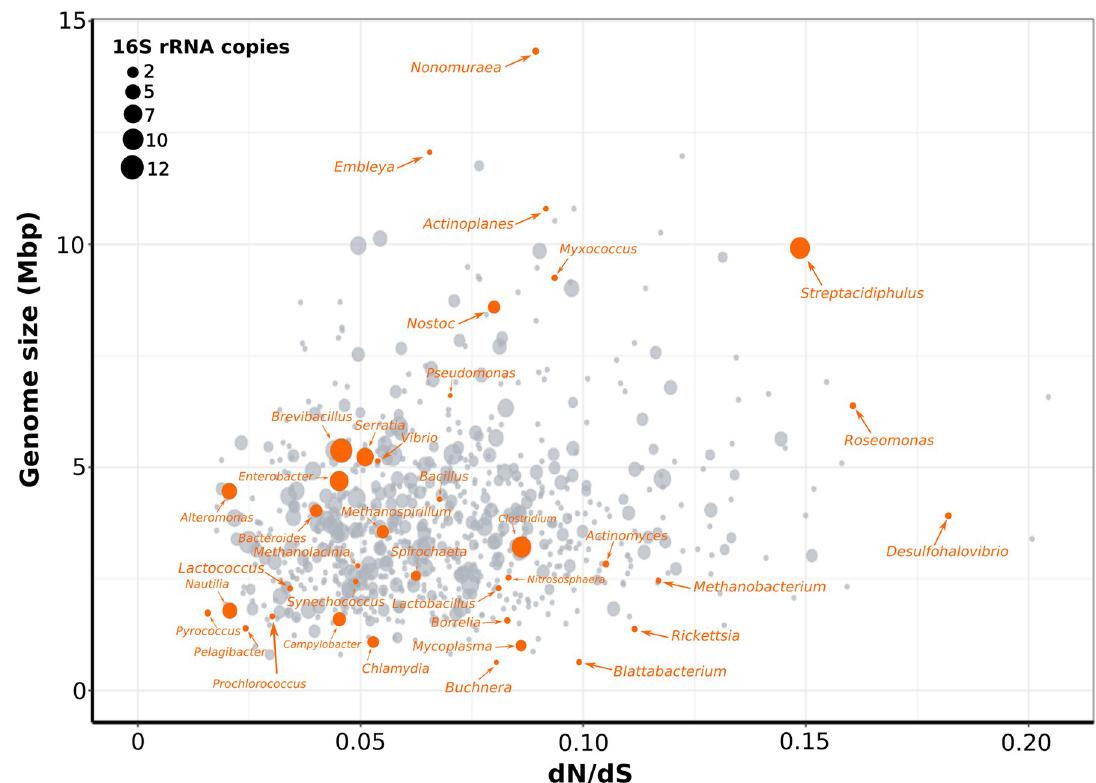
Fig 4. Relationship between genome size and dN/dS. dN/dS values represent the median estimate for each genus cluster. Dots represent a representative genome for each genus and size is equivalent to the number of 16S rRNA gene copies. Raw data can be found in S2